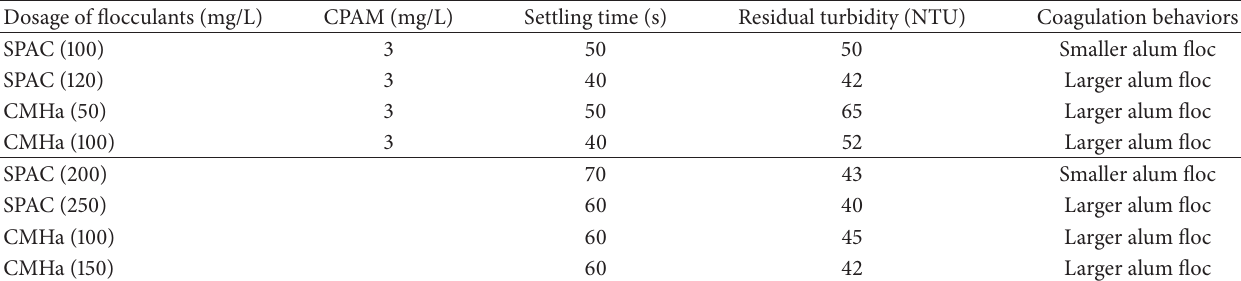
Table 14: Coagulation behaviors of CMHa versus PAC for paper-making wastewater treatment (original wastewater 850 NTU). Dosage of flocculants